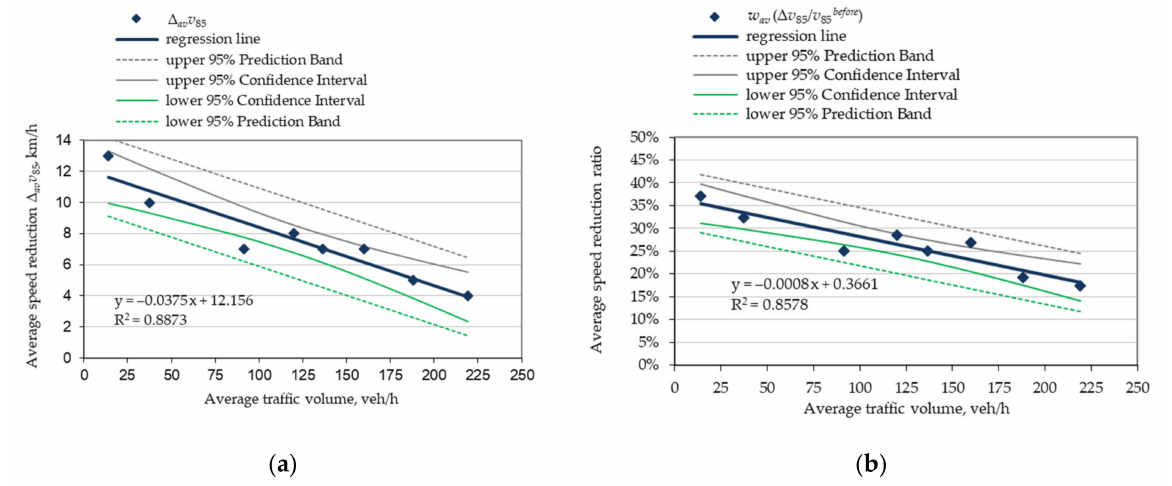
Figure 17. Regression analyses (testing ground No. 3) for the following relationships: ( a ) reduction in free-flow ∆ v 8 5 and average traffic volume ( R = − 0.94); ( b ) speed reduction ratio and average traffic volume ( R = − 0.93). Source: own work of the author.